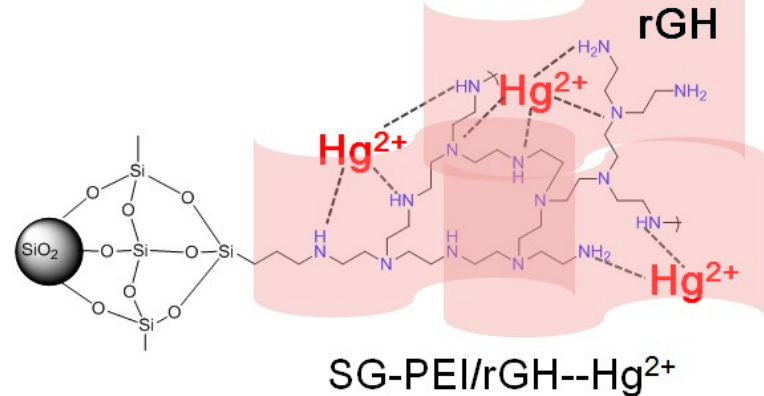
Figure 12. Mechanism for adsorption of Hg(II) on SG-PEI/rGH.